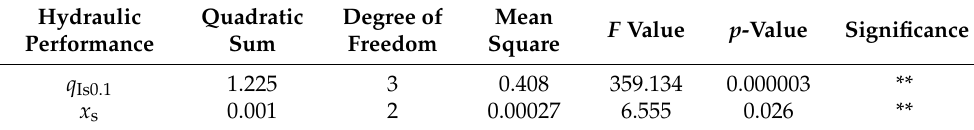
Table 7. Multivariate linear regression equation analysis of variance.